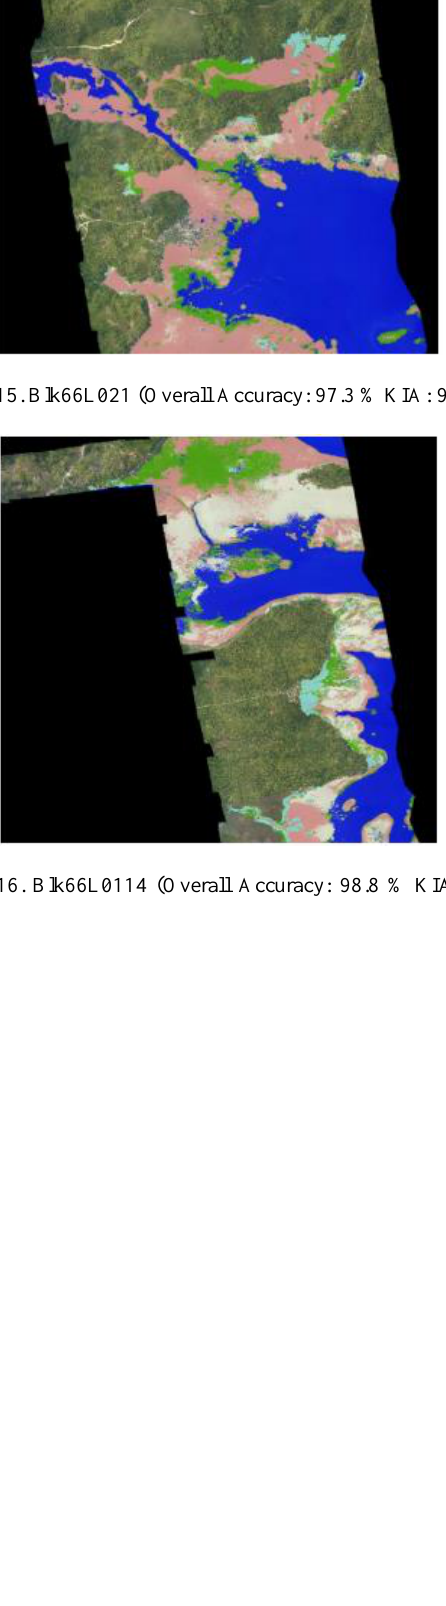
Figure 14. Blk66L024 (Overall Accuracy: 96.3 % KIA: 95 %)